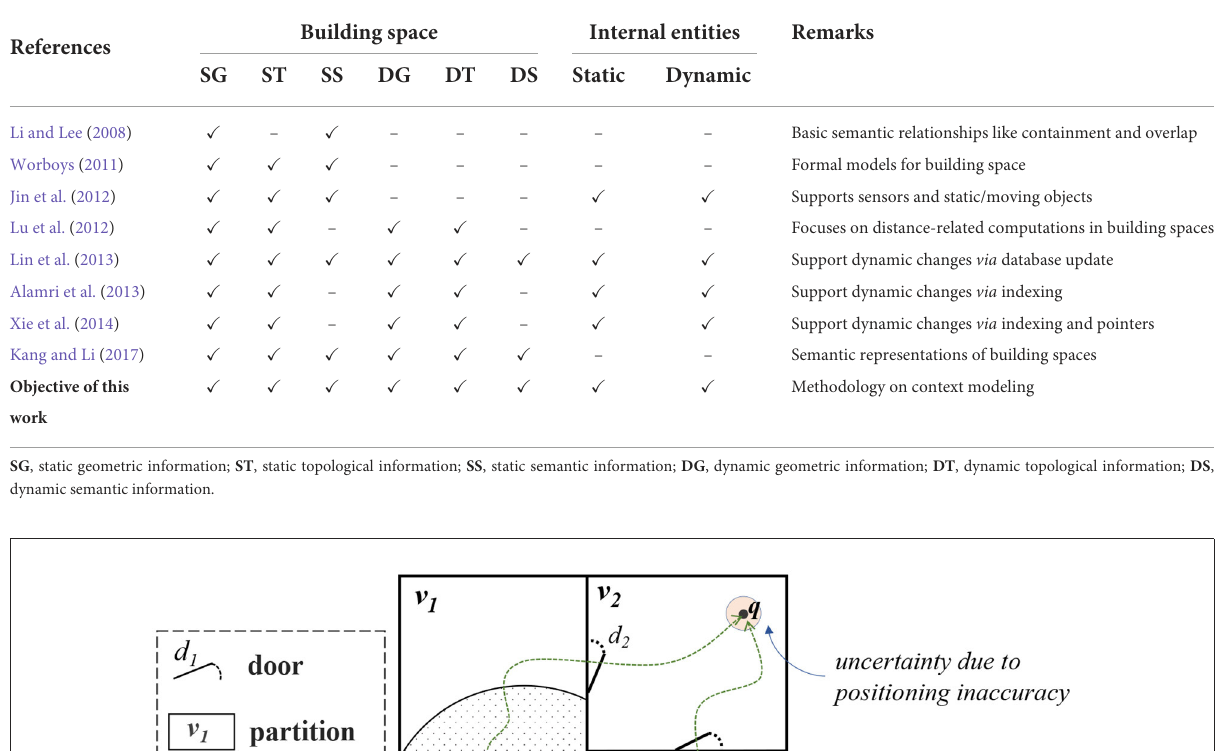
TABLE 1 Featural comparison of representative studies on intelligent building context modeling.